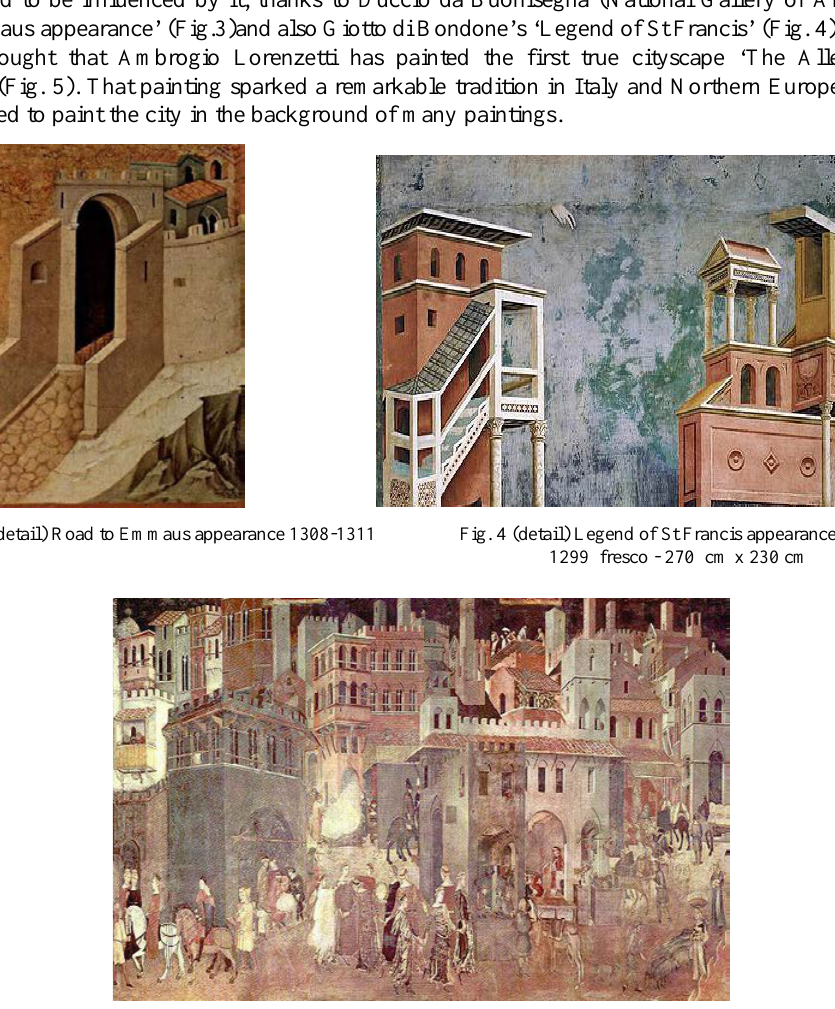
Fig. 5 The Allegory of Good Government -1338 - 1339 -200×770 cm